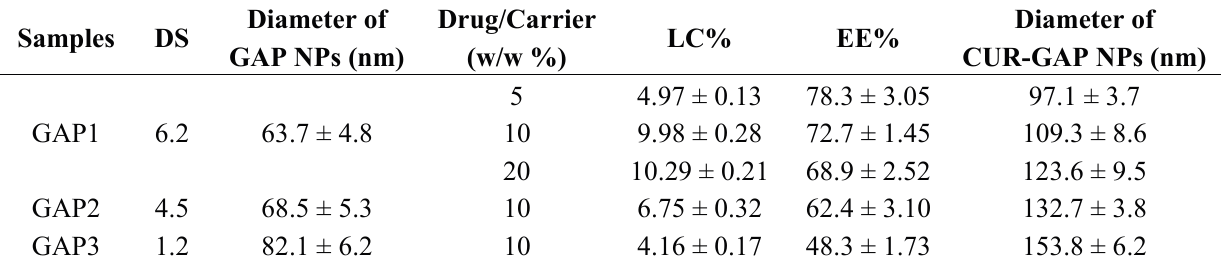
Table 1. The degree of substitution (DS) and diameter loading capacity (LC) and encapsulation efficiency (EE) of GAP NPs and CUR-GAP NPs. Data are mean ± SD, n = 3.